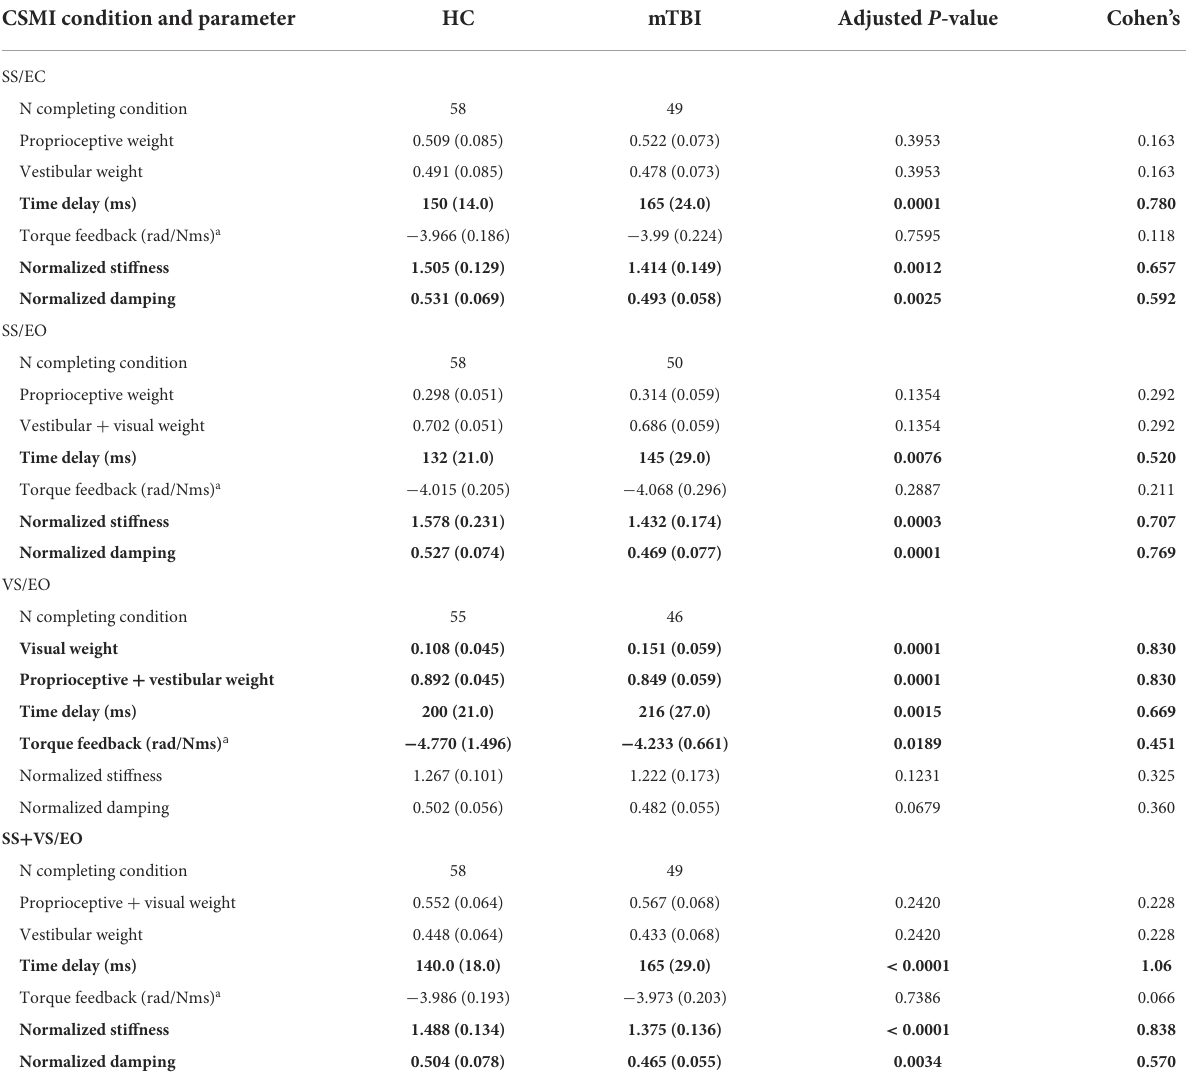
TABLE 3 Central Sensorimotor Integration (CSMI) test model-derived parameters for healthy controls (HC) and chronic mild traumatic brain injury (mTBI) groups. CSMI condition and parameter HC mTBI Adjusted P -value Cohen’s d